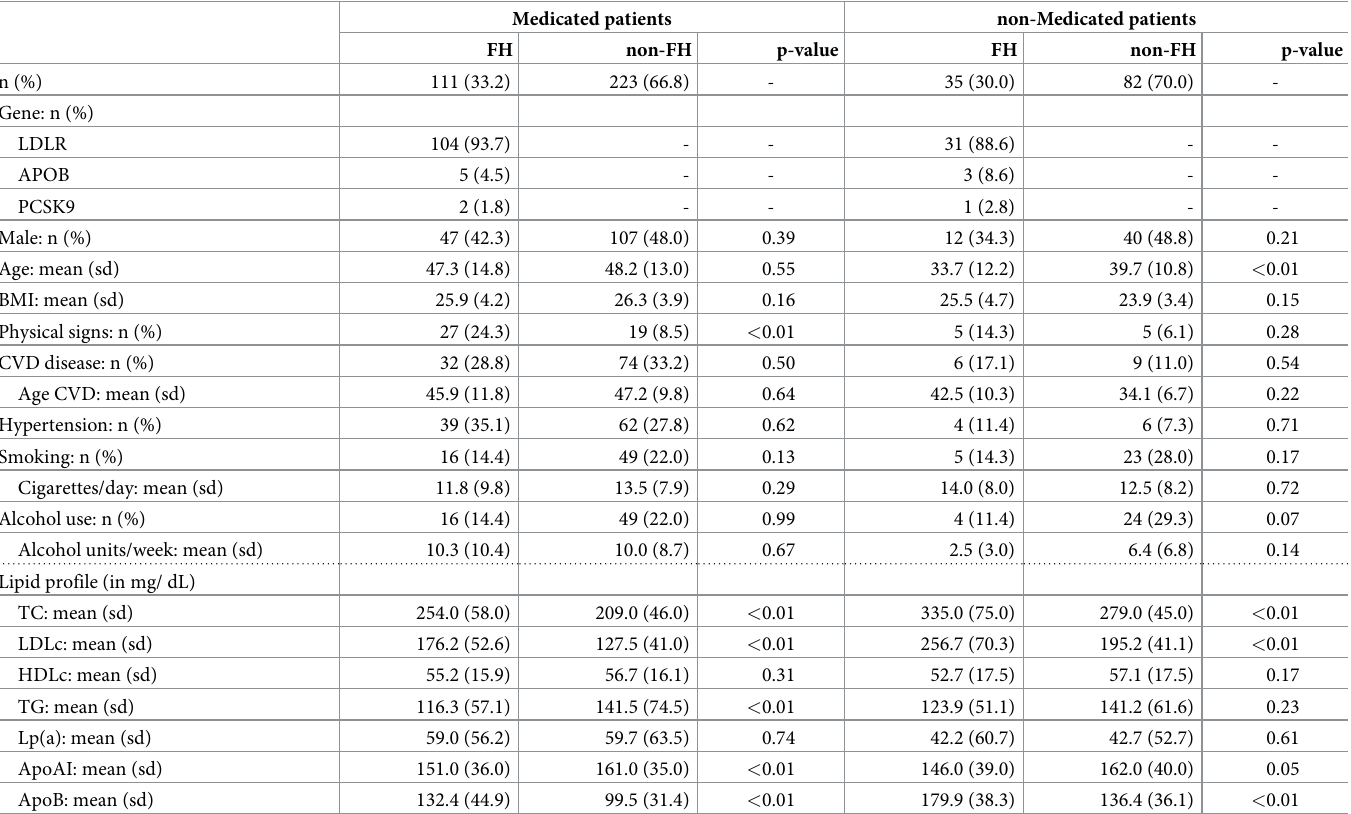
Table 2. Comparison of biological and biochemical values between FH and non-FH patients, according to statins usage. Medicated patients non-Medicated